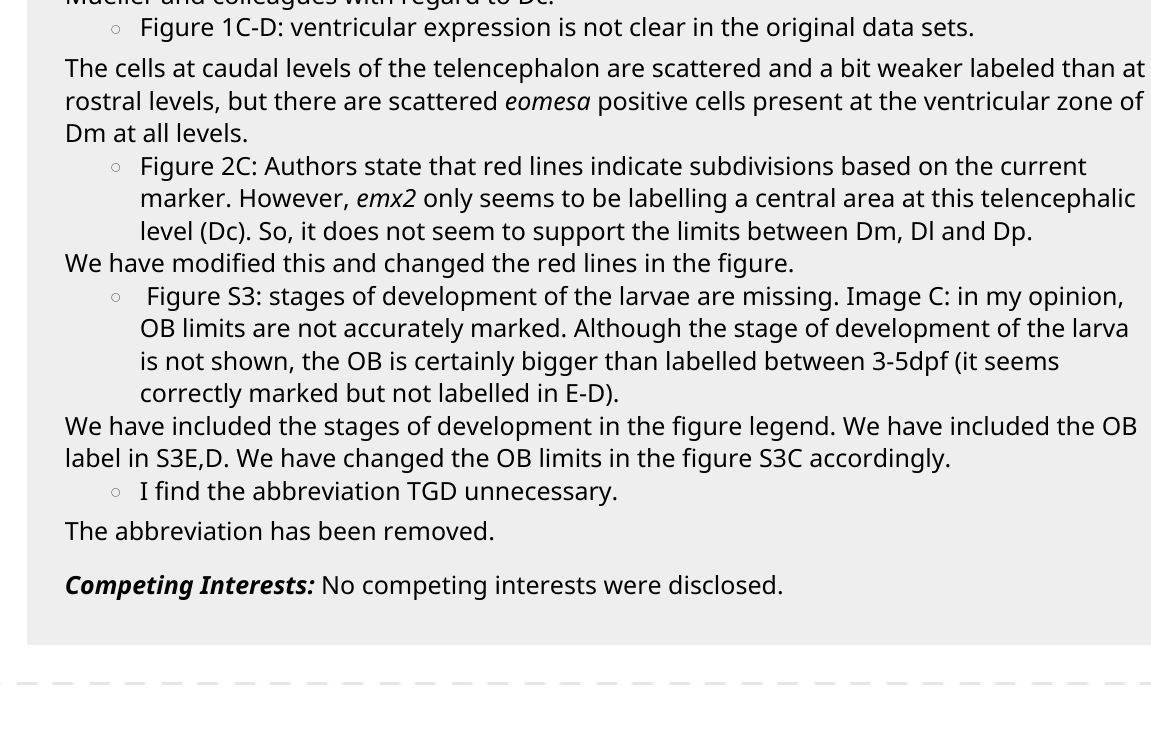
Figure 2C: Authors state that red lines indicate subdivisions based on the current